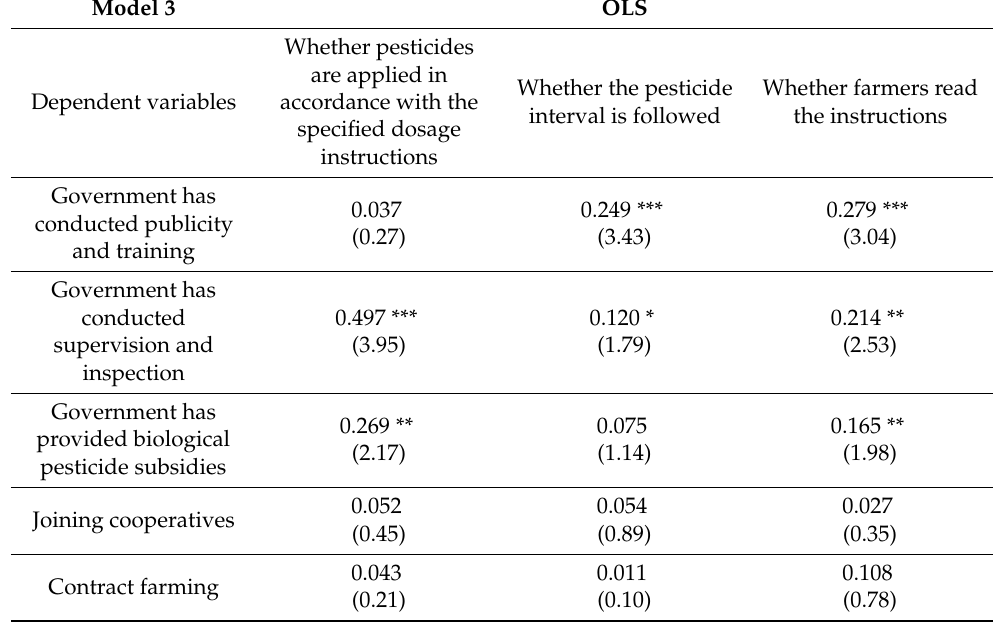
Table 5. Testing the mediation